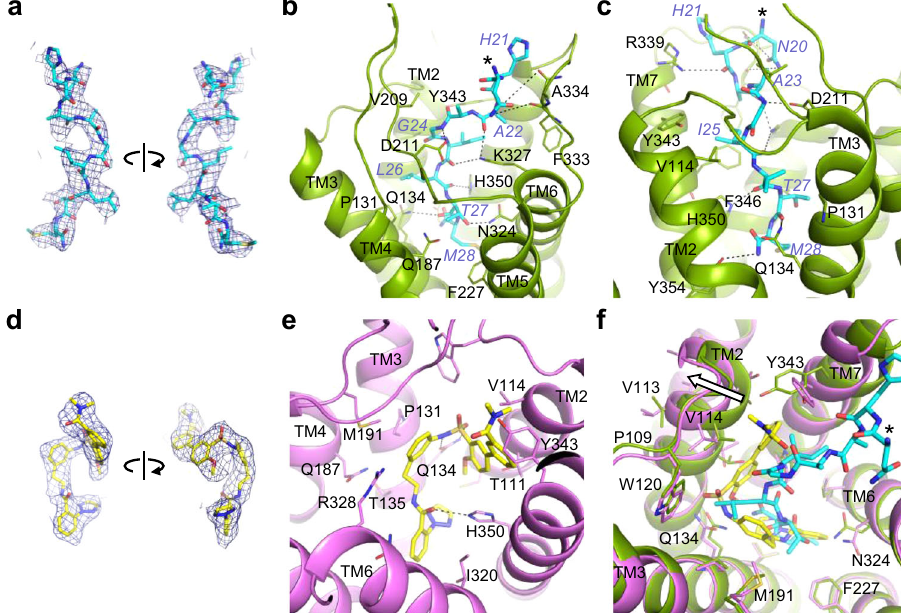
Fig. 3 Small-molecule and peptide agonist recognition. a Electron density map (blue mesh) around residues N20 – M28 of OxB (cyan) viewed from two angles. b , c Two different views of the detailed interactions of OxB and OX 2 R (green). d Electron density map (blue mesh) around compound 1 (yellow) viewed from two angles. e Detailed interactions of compound 1 with OX 2 R (purple). f Overlay of the binding sites with OxB and compound 1 . Residues 192 – 214 of ECL2 have been removed for clarity. The asterisks in a , c , and f indicate the position of the mainchain nitrogen of N20 of